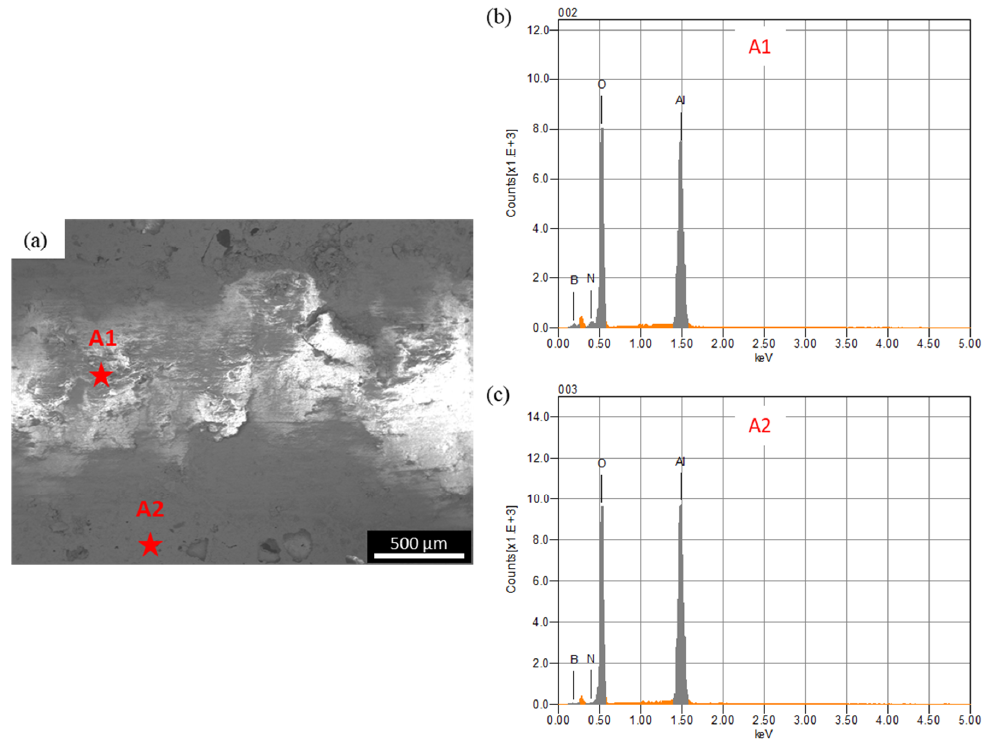
Figure 8. ( a ) SEM micrograph of the wear track on B20 composite against alumina ball; ( b ) and ( c ) are the EDS spectrum at A1 and At2, respectively.